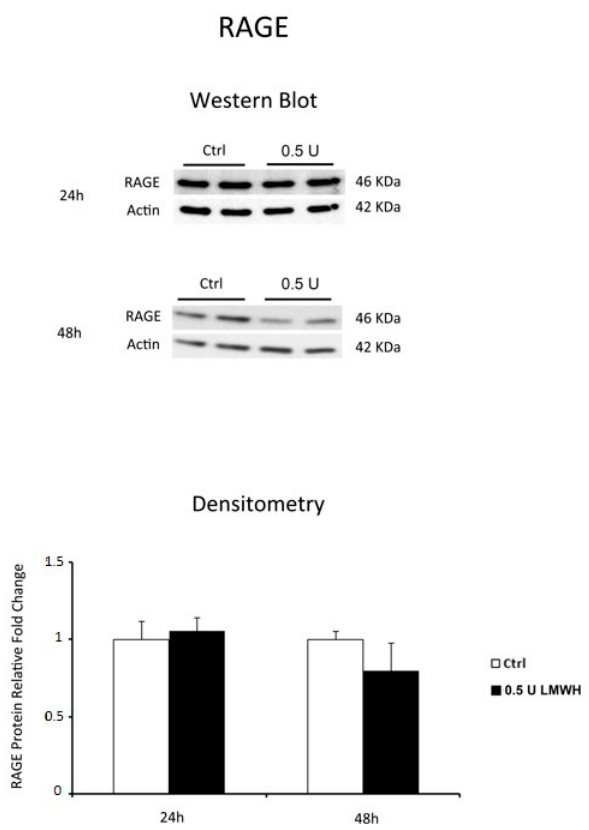
Figure 3. RAGE expression in LMWH-treated vs. untreated physiological placental villous explants. Representative western blot for RAGE protein expression level in physiological term placental villous explants treated for 24 h (ctrl n = 7 and 0.5 U LMWH n = 7) and 48 h (ctrl n = 10 and 0.5 U LMWH n = 10) by 0.5 U of LMWH.